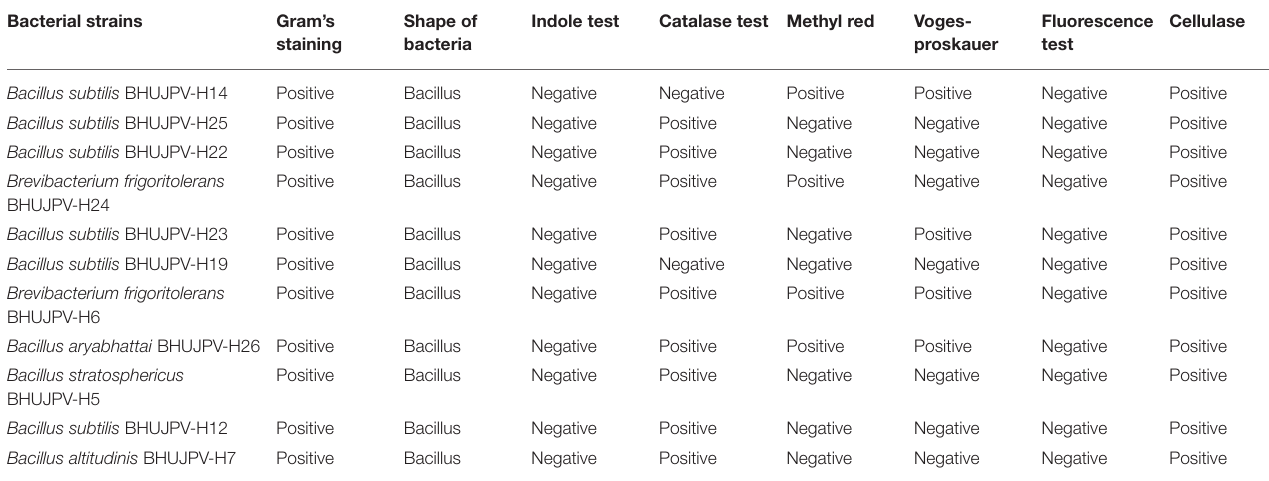
Shape of Indole test Catalase test Methyl red Voges- staining bacteria